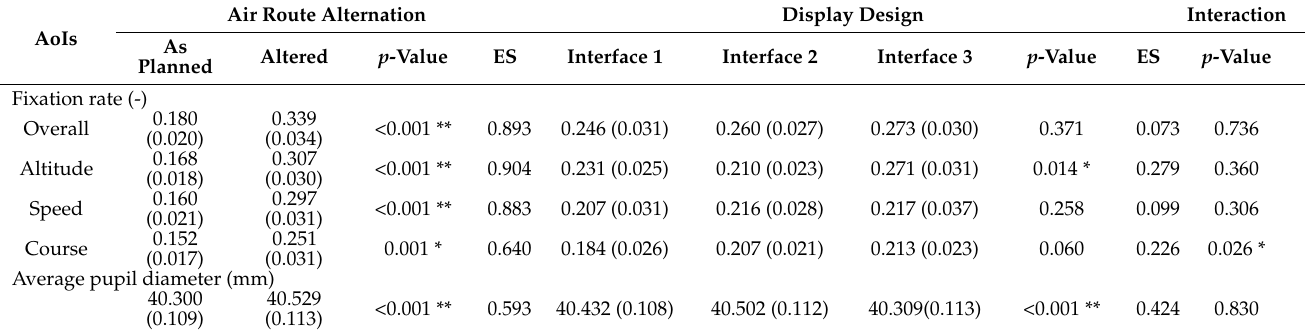
Table 3. ANOVA results for the eye movement measures (mean